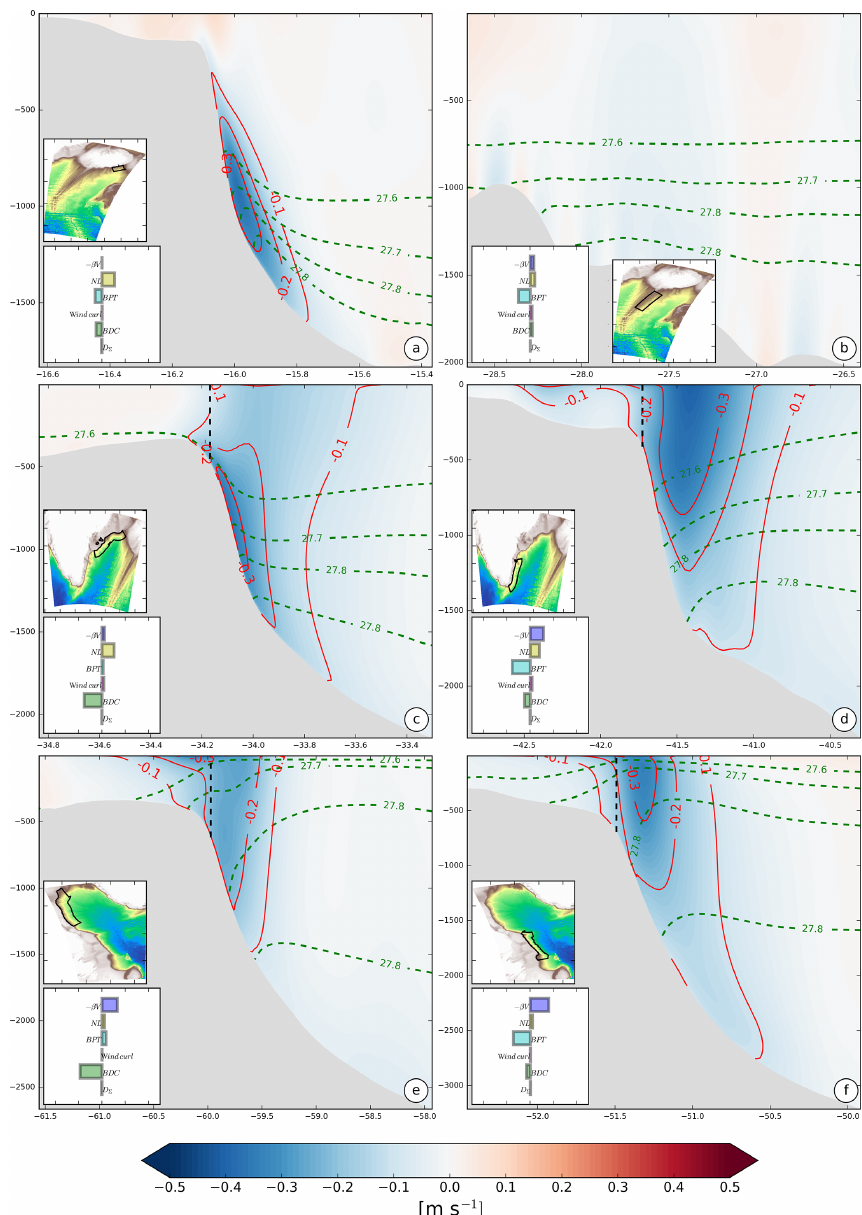
Figure 12. Vertical section of the mean along-stream current near the Iceland shelf (a) , eastern Reykjanes Ridge (b) , Denmark Strait (c) , eastern Greenland (d) , northern Labrador Current (e) , and southern Labrador Current (f) . Red solid lines and green dashed lines are velocity and surface-referenced potential density contours, respectively, while the black dashed line is the limit of integration near the shelf. The black contour on the topography map represents the area on which barotropic vorticity terms are